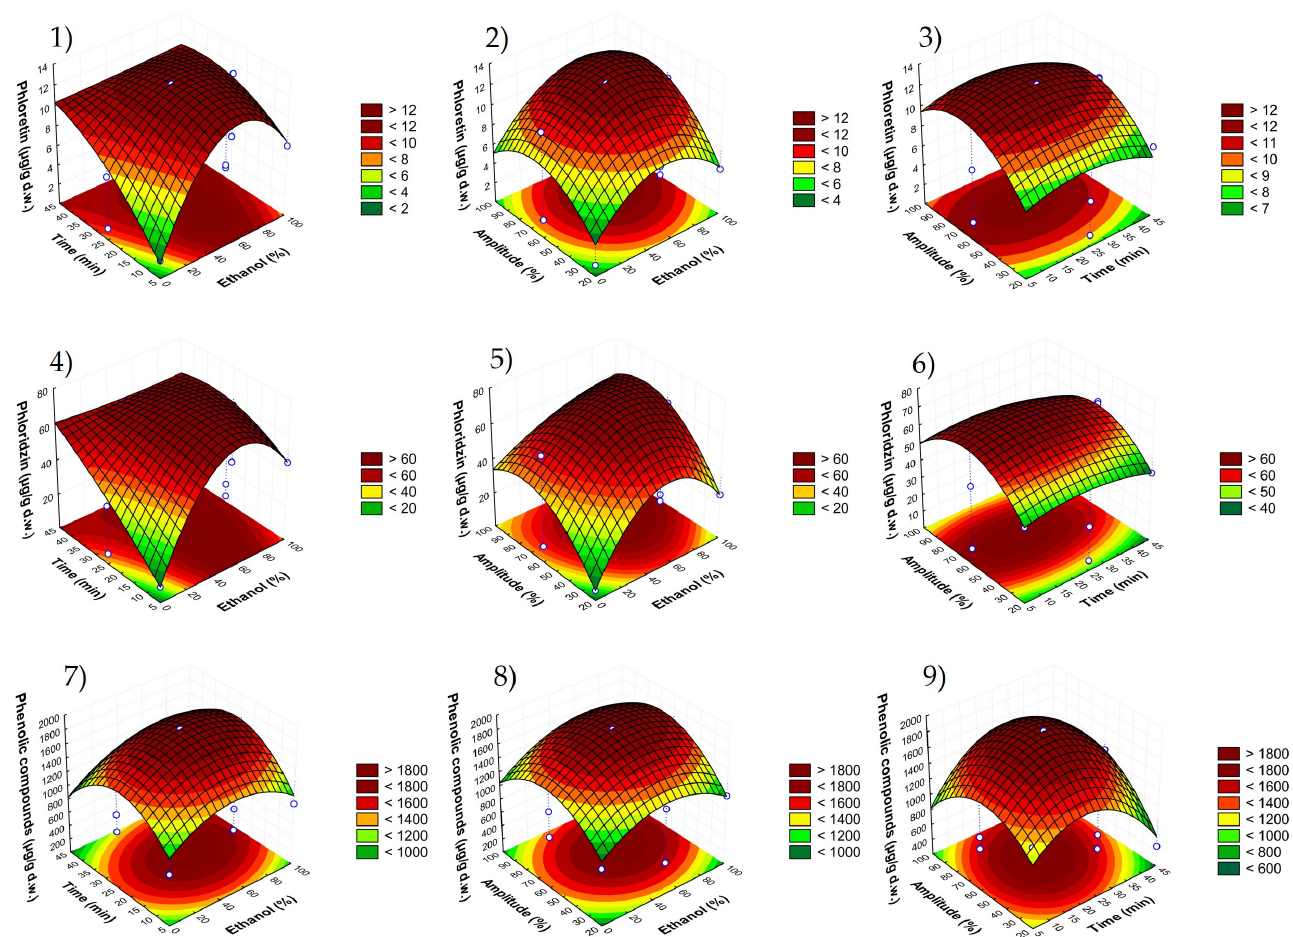
Figure 2. Response surface graphs (1–9) showing the combined effects of the process variables: ethanol (%), time (min) and amplitude (%) for the response variables 1–3: phloretin; 4–6: phloridzin; 7–9: sum of phenolic